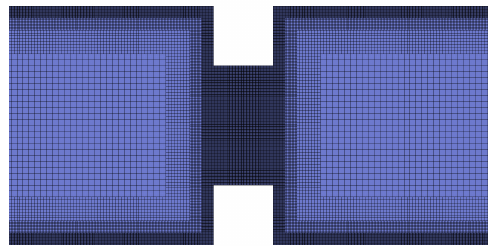
Figure 3. Illustration of the mesh used to the electro-osmotic simulations in a nozzle. This mesh has 4 levels of refinement.